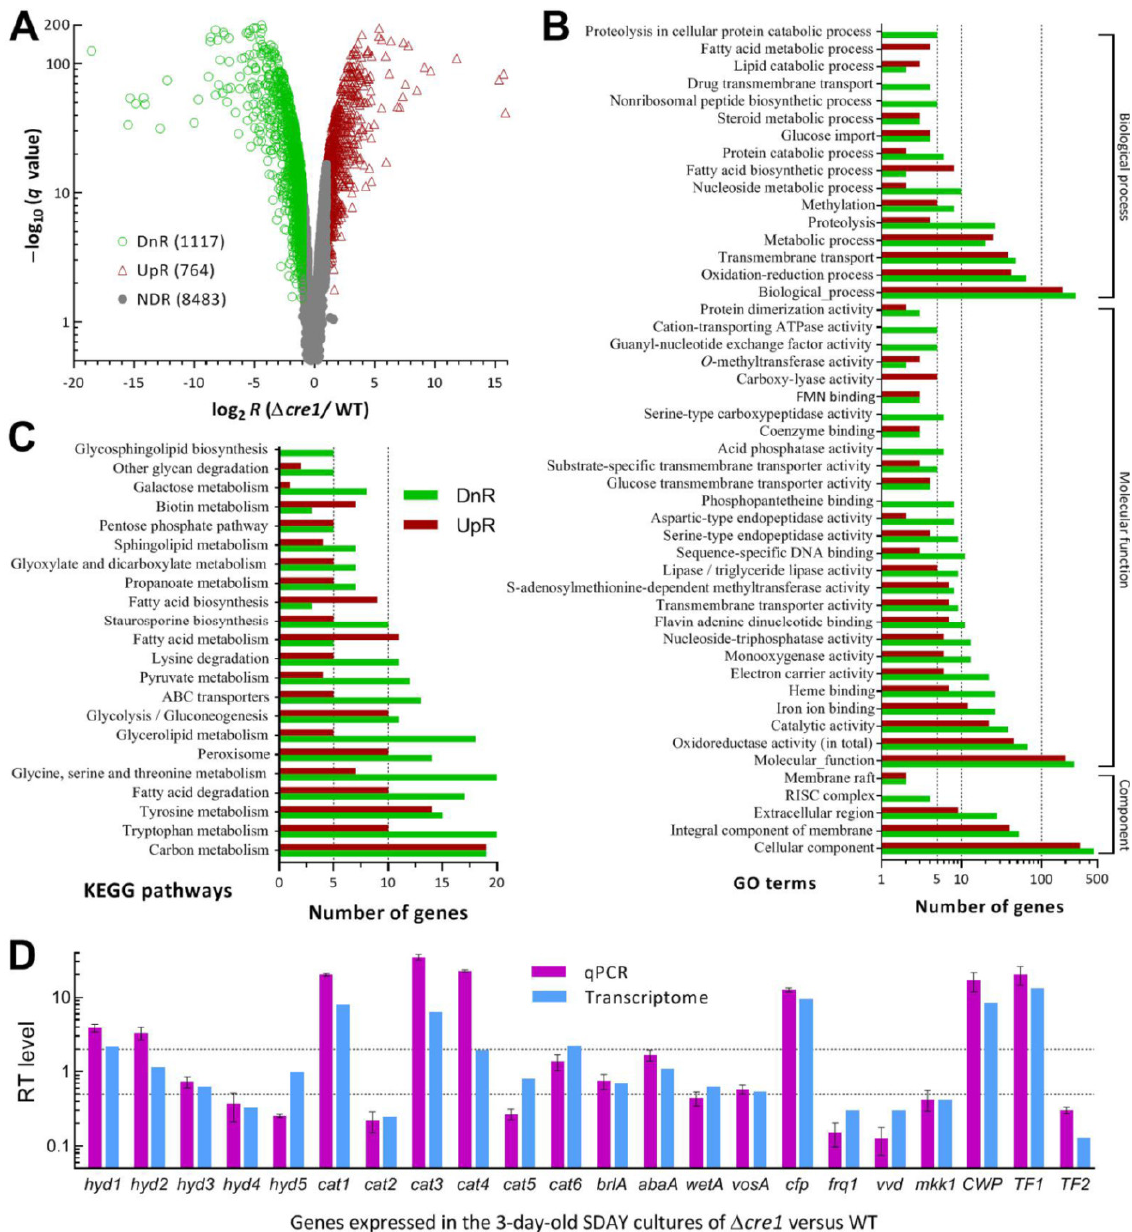
Figure 5. Genome-wide regulatory role of Cre1 in B. bassiana . ( A ) Distributions of log 2 R ( ∆ cre1 /WT) values versus − log 10 q values for all genes significantly upregulated (UpR; log 2 R ≥ 1, q < 0.05), downregulated (DnR; log 2 R ≤ − 1, q < 0.05) or not differentially regulated (NDR; log 2 R < 1 or > − 1, q ≥ 0.05 if log 2 R > 1 or < − 1) in the transcriptomes generated from three 3-day-old SDAY cultures (replicates) of ∆ cre1 and WT grown at the optimal regime of 25 ◦ C and L:D 12:12. ( B , C ) Counts of differentially expressed genes (DEGs) significantly enriched to GO function classes (only main GO terms shown) and KEGG pathways, respectively. ( D ) Comparison of anti-log 2 R values of 22 DEGs with their transcript (RT) levels in the 3-day-old SDAY cultures of the ∆ cre1 mutant relative to the WT standard. The upper and lower dashed lines denote the significant levels of log 2 R = 1 and log 2 R = − 1, respectively. Error bars: SDs of the means from three cDNA samples analyzed via qPCR with paired primers (Table